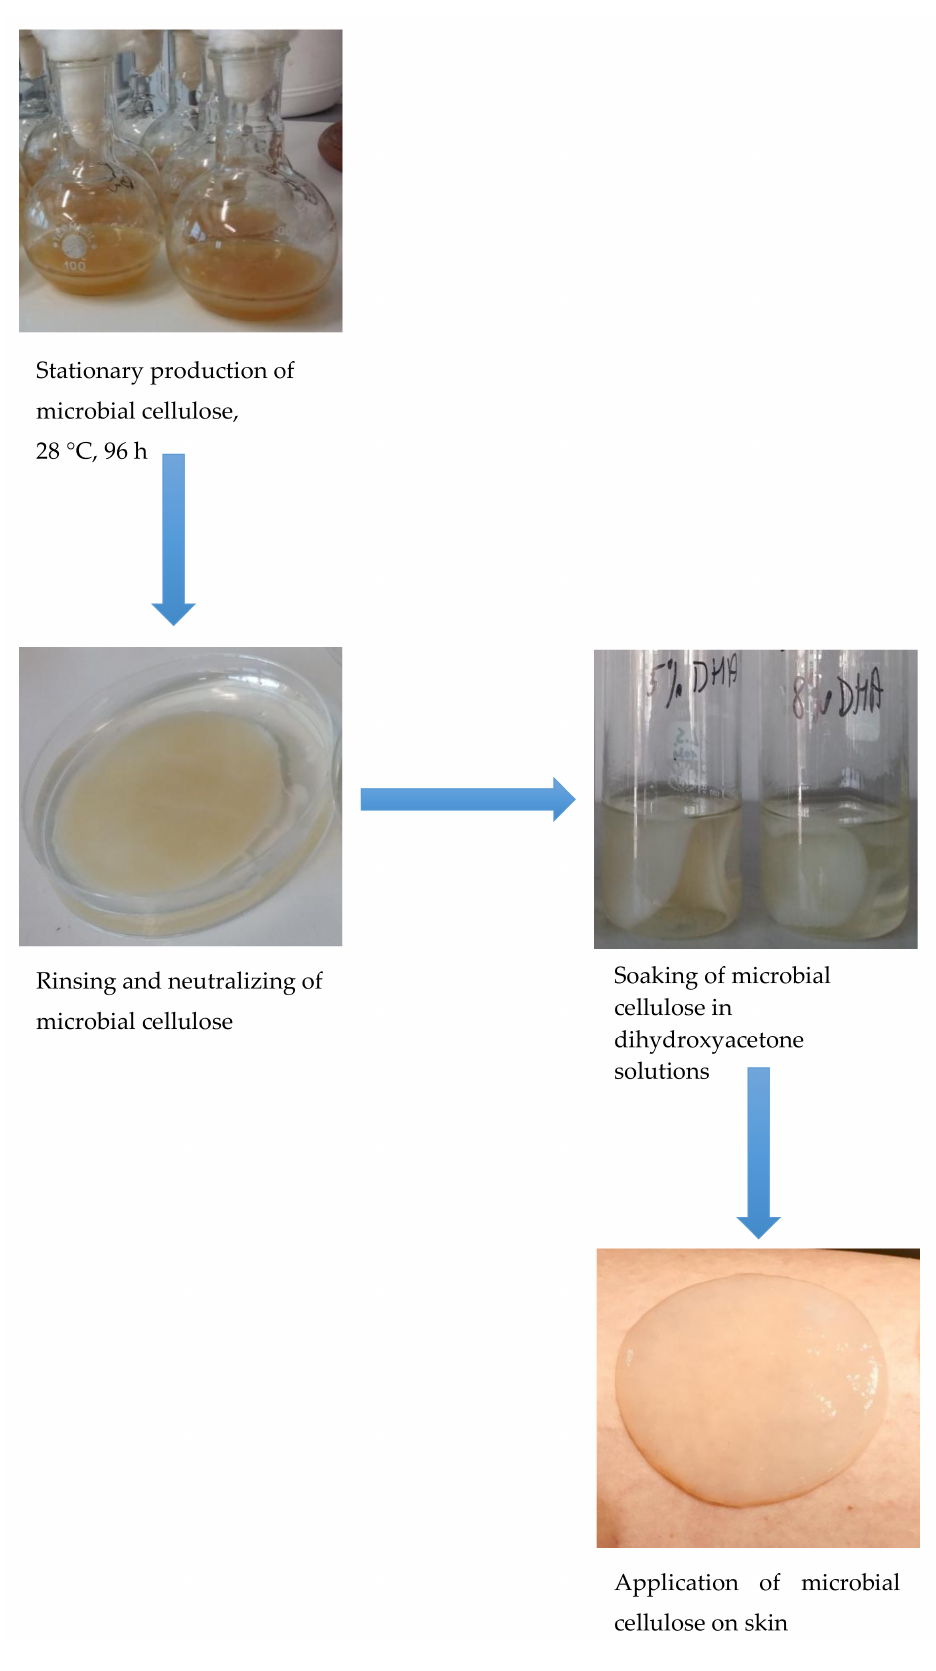
Figure 3. Process of preparing MC patches with